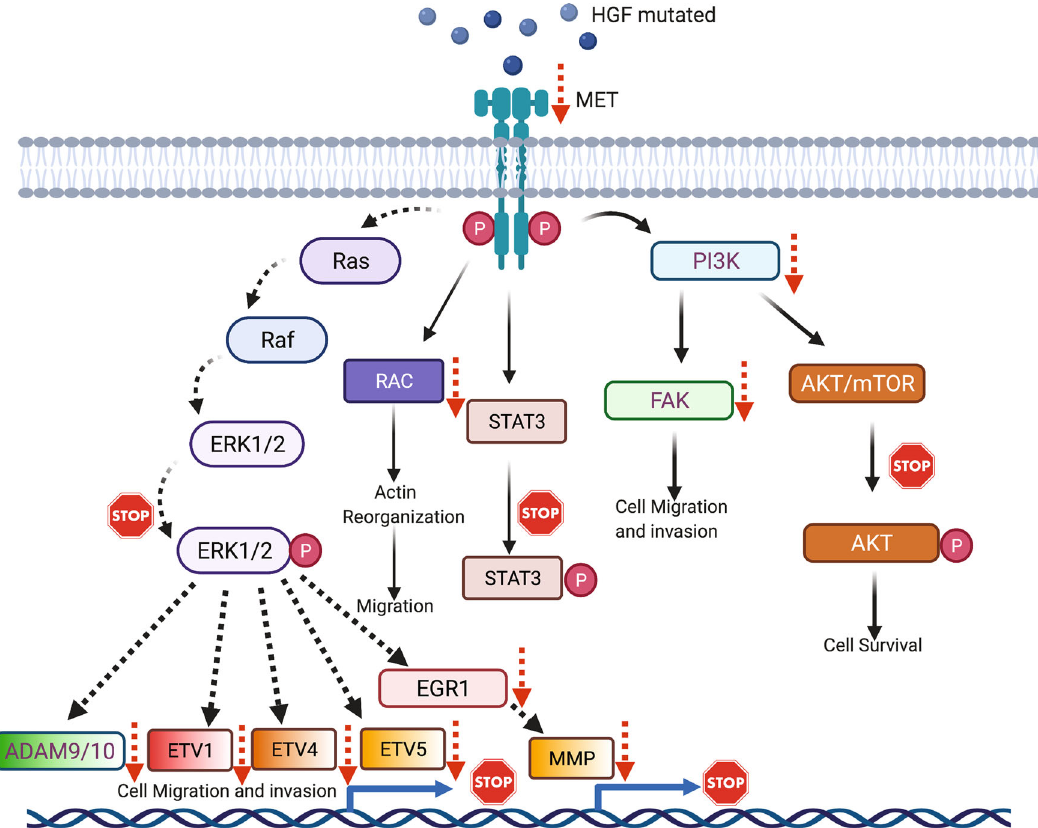
Fig. 5 A proposed model showing how conserved cysteines in HGF PAN domain determines the fate of c-MET signaling cascade. PAN domain provides the catalytic core to HGF for c-MET interaction leading towards initiation of the entire downstream HGF/c-MET axis. Alteration in conserved cysteine residues blocks the activation of several transcription factors and effector molecules which otherwise stimulate cell migration, cell invasion, proliferation, and cell motility. Figure created with